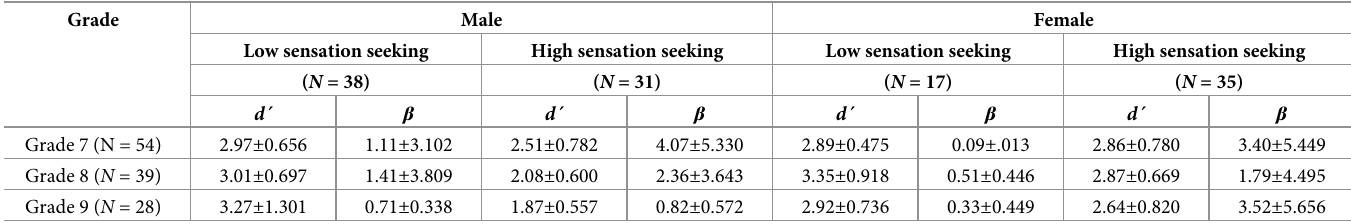
Table 4. Mean and standard deviations of sensitivity d and judgment criterion when crossing road for adolescents (s) .